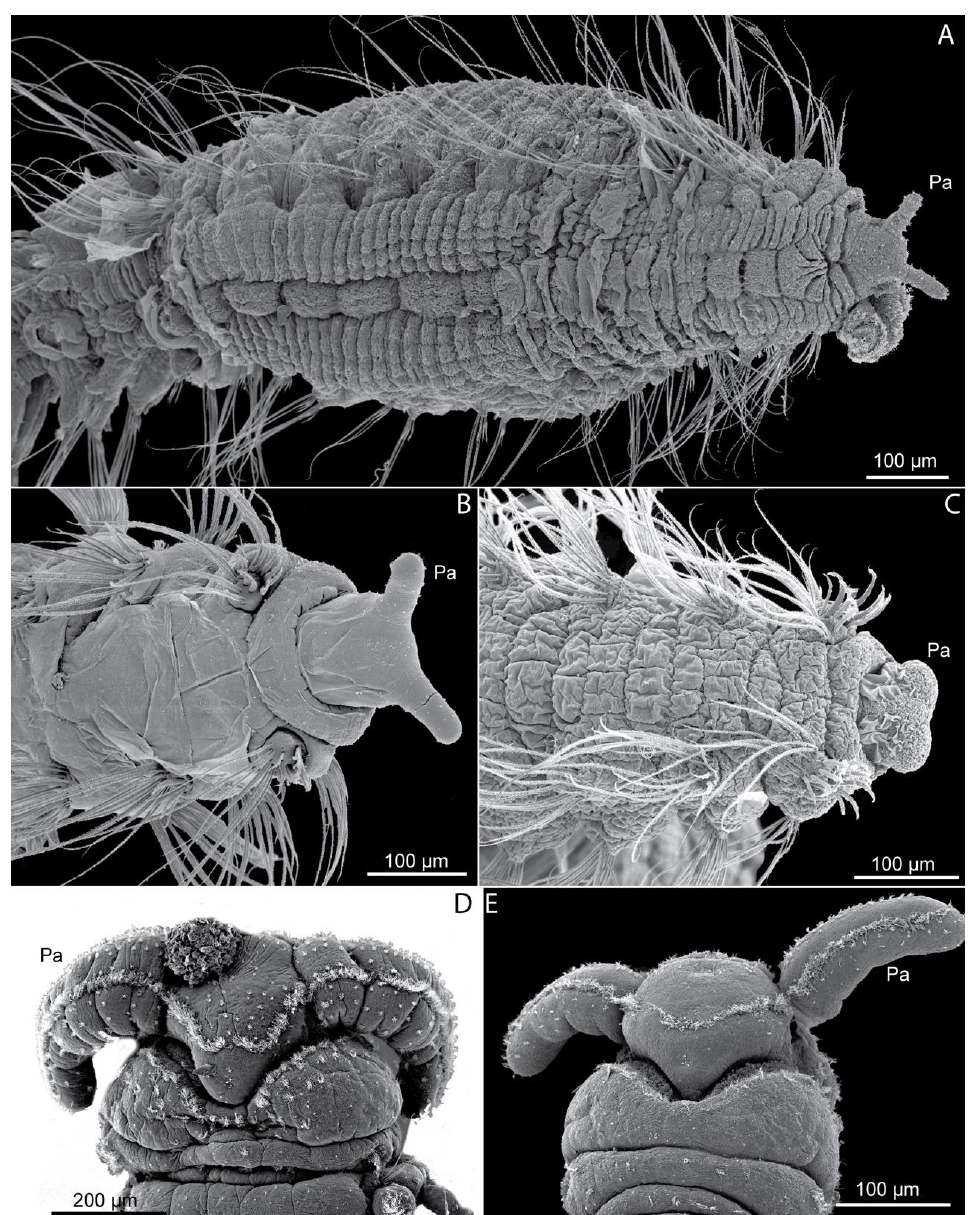
Figure 10. SEM micrographs of several Scalibregmatidae showing main prostomial diagnostic characters. ( A ) Pseudoscalibregma sp., Canary Islands, anterior end in ventral view, showing the pattern formed by the pads as well as the structure of the parapodia; ( B ) Asclerocheilus sp., Canary Islands, anterior end in dorsal view; ( C ) Asclerocheilus sp., northwestern Spain, anterior end in dorsal view; ( D ) S. lanzaroteum, anterior end in dorsal view; ( E ) A. cavernicola , anterior end in dorsal view. Notice the difference in the prostomial shape and appendages amongst B – E, as well the presence of differ- ent development of the peristomium, and the presence of different types of chaetae. Abbreviation: Pa — prostomial appendages.